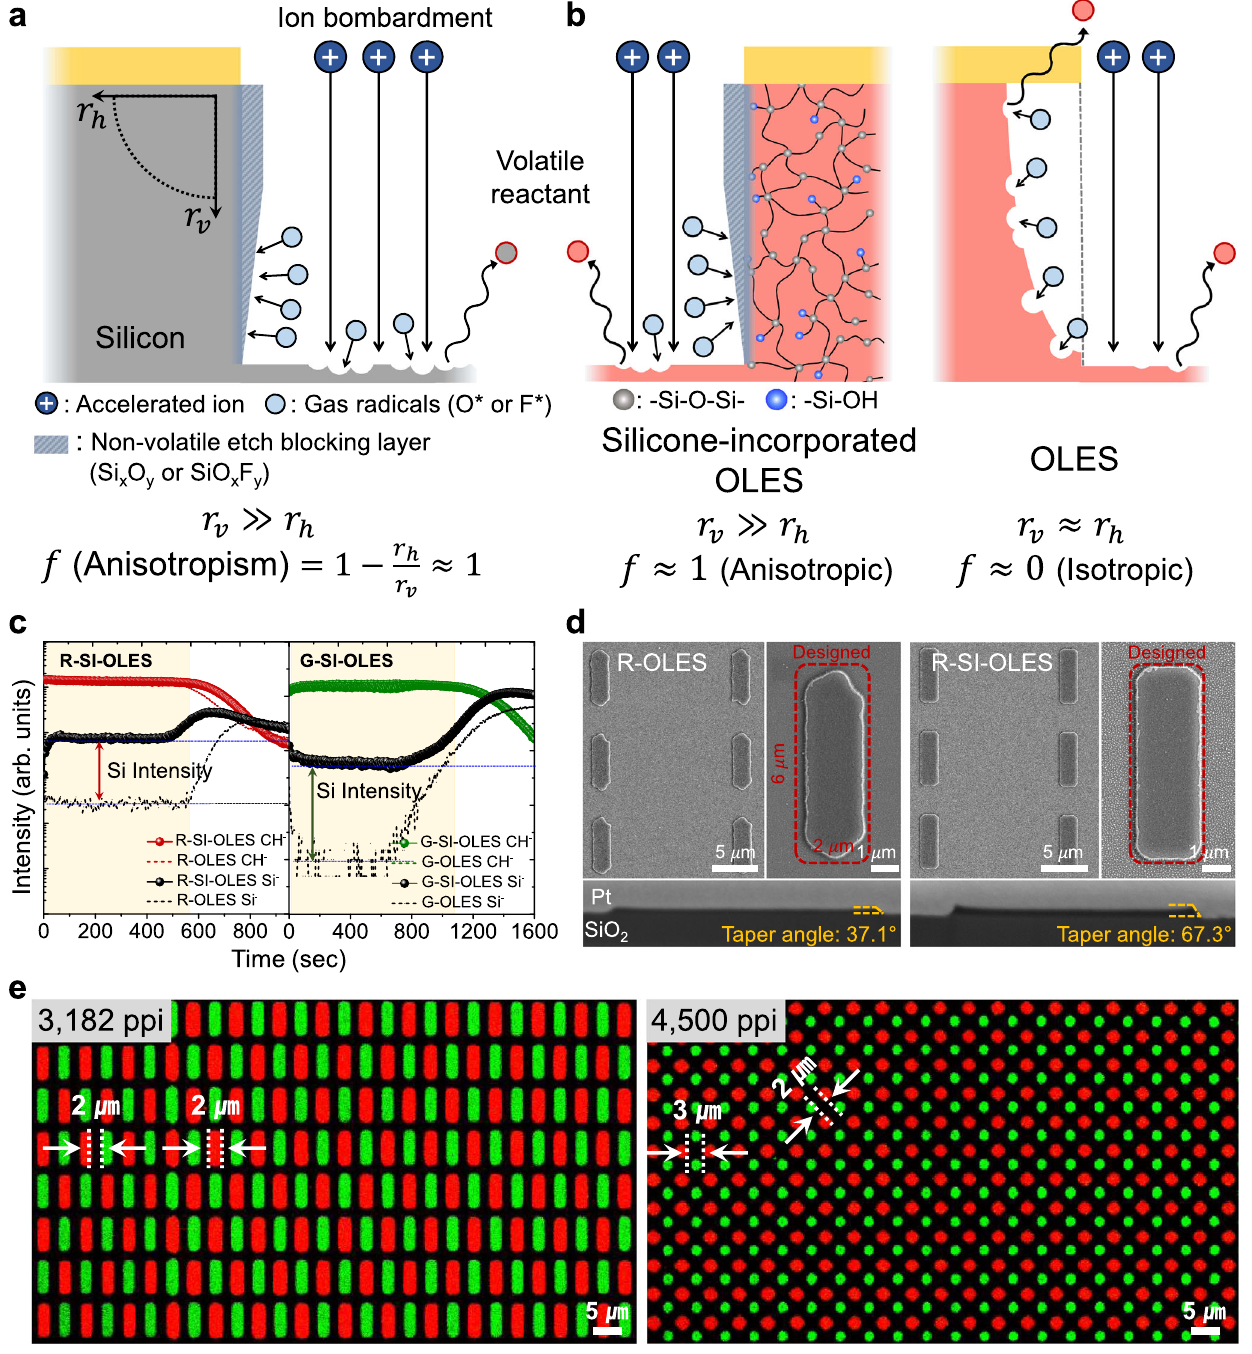
Fig. 1 | Anisotropic lithography mechanism and characteristics ofthe SI-OLES. a RIE-based conventional anisotropic etching mechanism of the silicon (Si). b Conceptualschematicillustrationofanisotropicetchingbehaviorinducedbythe non-volatile EBL in the SI-OLES. c ToF-SIMS pro fi les of the R/G-OLES and R/G-SI-